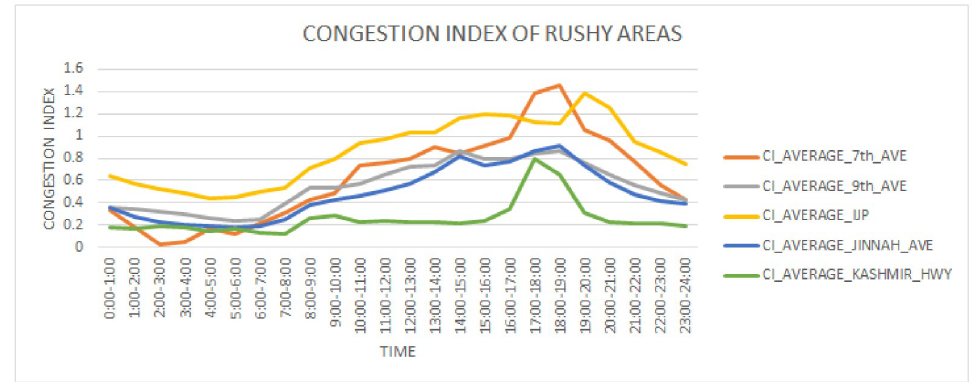
Fig 6. Congestion index trends in rushy